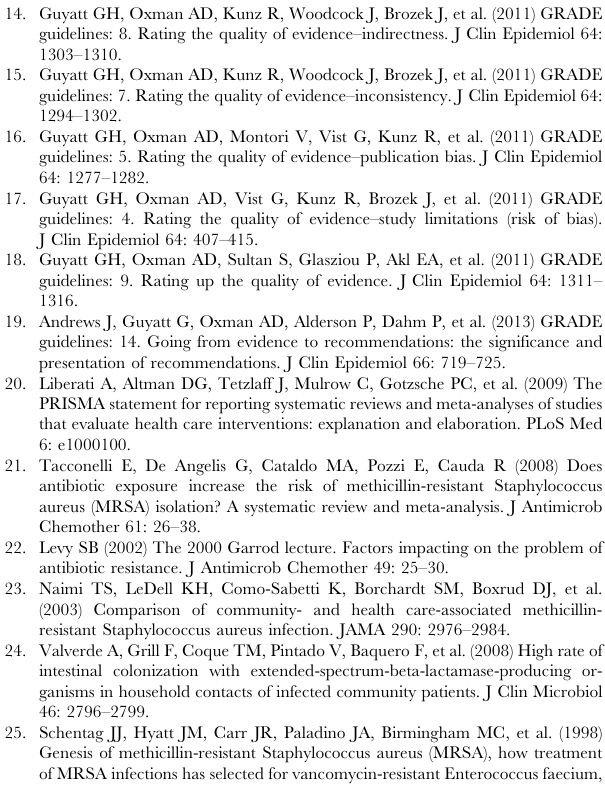
illustrating the literature selection process, and Table S3 illustrating evidence assessment for the third query.